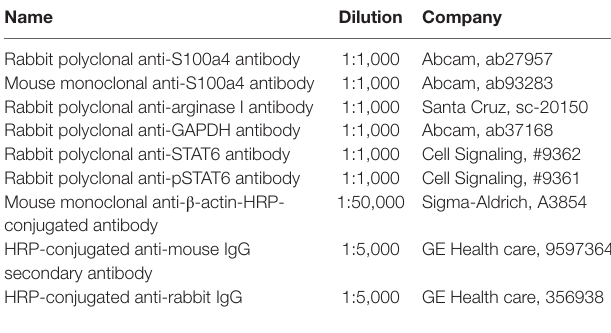
TaBle 2 | Antibodies utilized in western blot